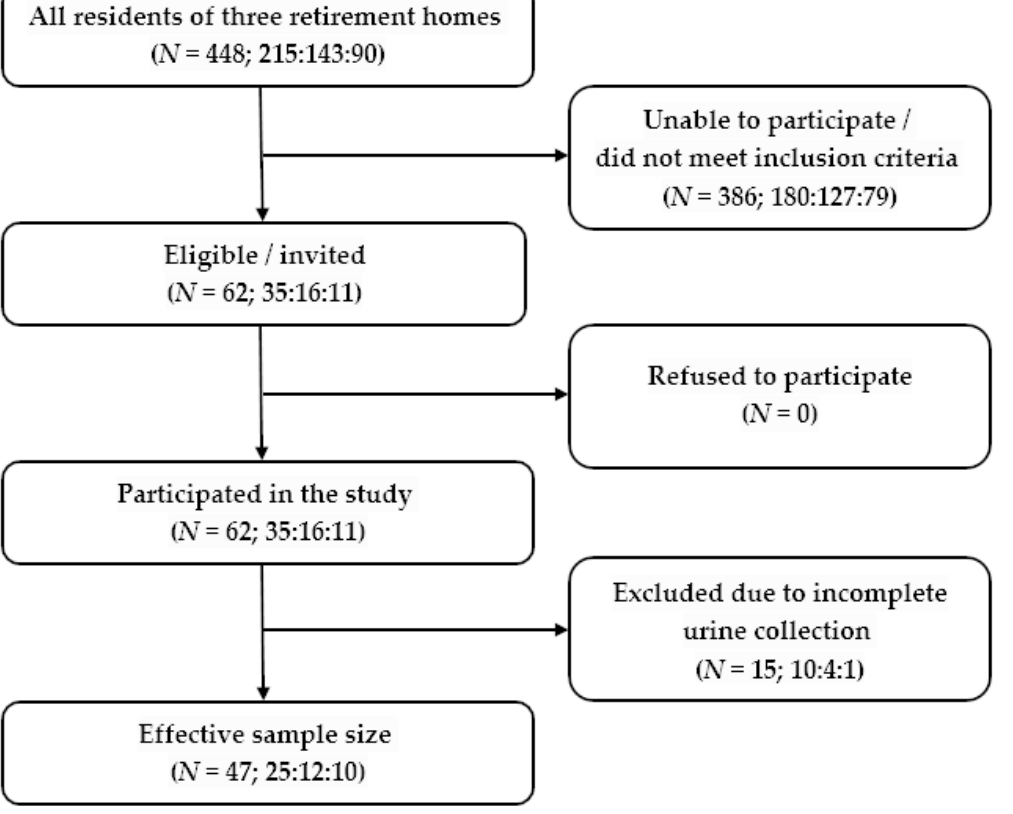
Figure 1. Study flow chart—62 residents of retirement homes were recruited to participate in the study, as they met the inclusion criteria. The effective sample size after the exclusion of subjects with incomplete urine collection was 47 participants.